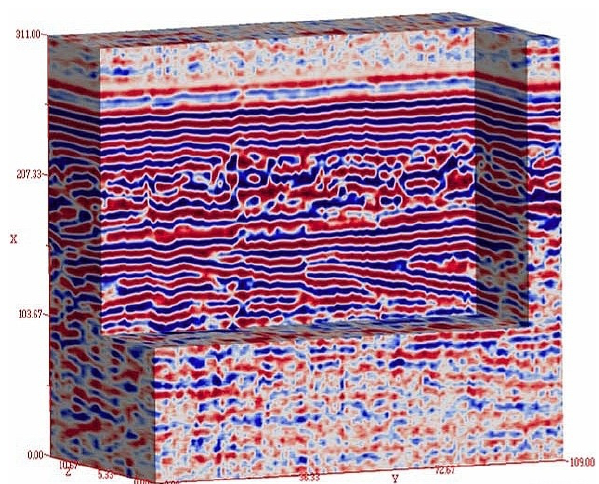
Fig. 5. GPR survey at the Cave of Letters (Dead Sea): 3-D cube with electric resistivity tomography lines and archaeological cave floor exposed (after Reeder et al., 2004).